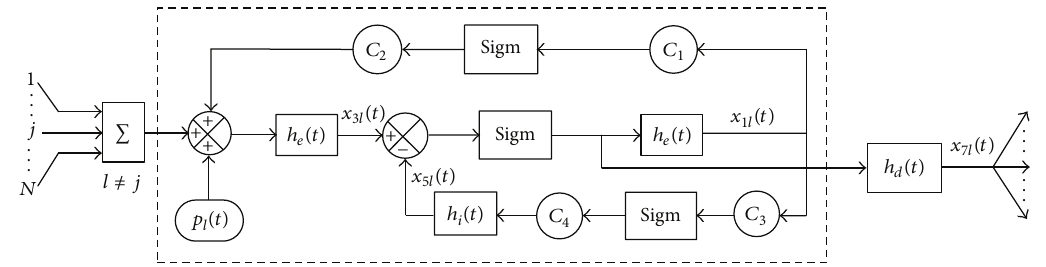
Figure 1: Elementary model for a given population 𝑙 .